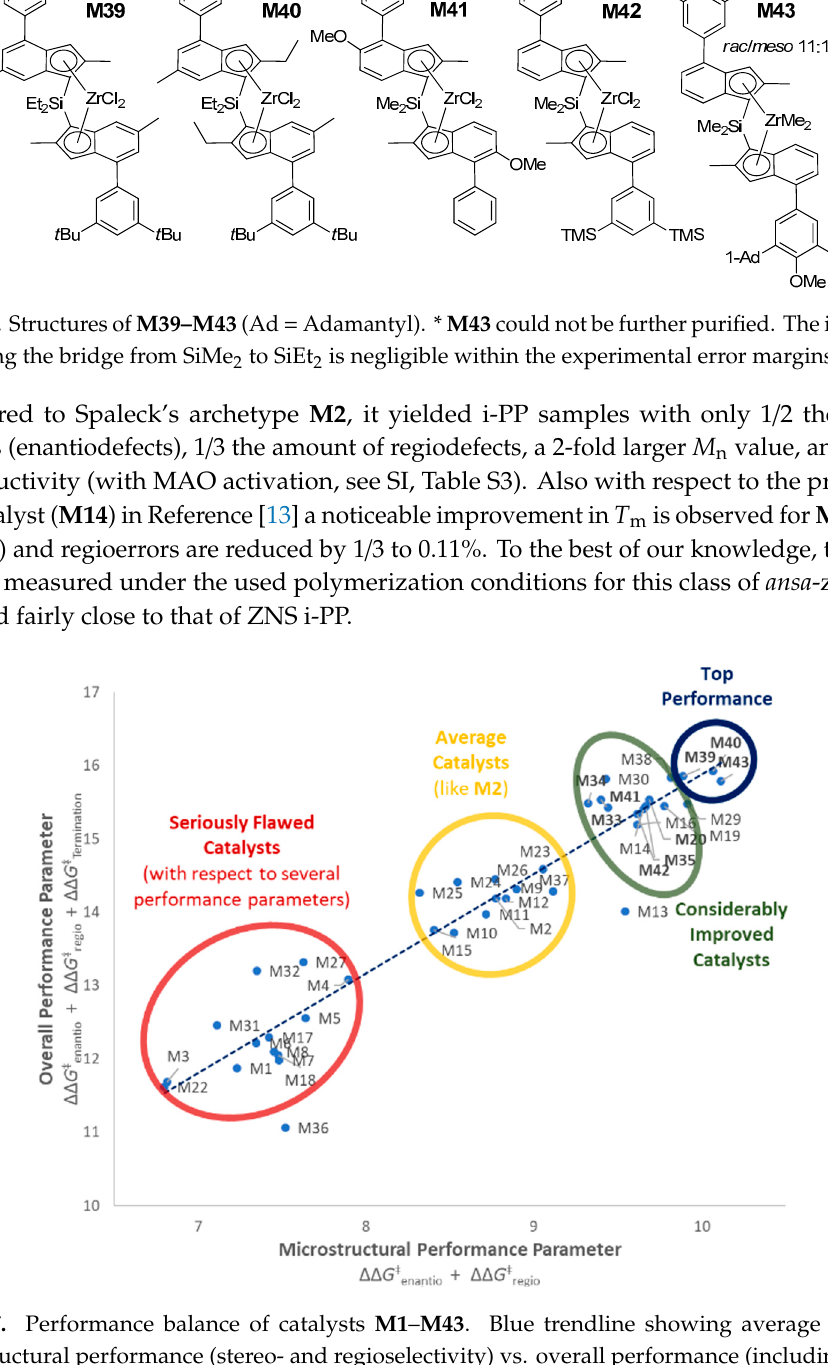
Figure 7. Performance balance of catalysts M1 – M43 . Blue trendline showing average trend of microstructural performance (stereo- and regioselectivity) vs. overall performance (including molar mass capability). Catalysts on the left of this line show higher molar mass capabilities than would be expected by this trend, catalysts on the right show lower ones. Three distinct catalyst groupings can be observed (seriously flawed to considerably improved). Nine out of 15 catalysts with considerable performance improvement (in bold) have been first reported in this manuscript, including the most balanced ones M39 , M40 , and M43 (top performers).